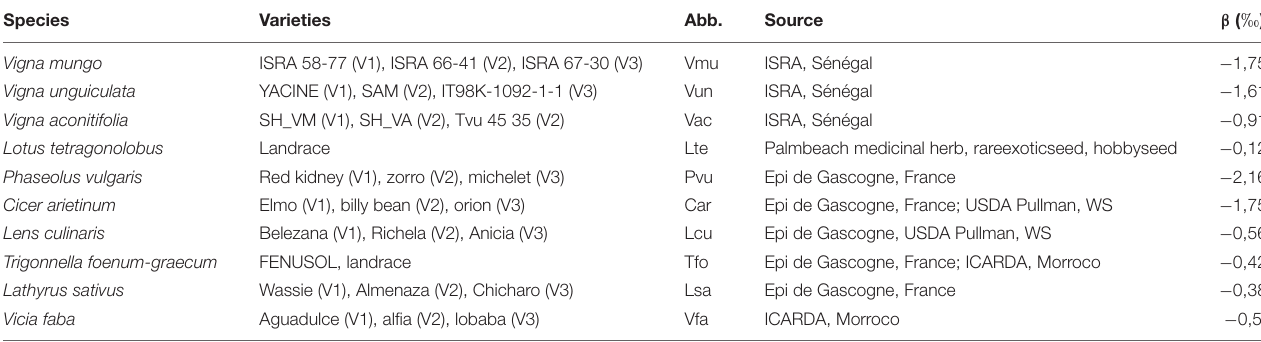
TABLE 1 | List of the 10 species included in the experiment with a description of the three varieties associated to each species, the abbreviation (Abb.) used in the study, sources of the seeds, and the ß value used for %Ndfa computation. Species Varieties Abb.